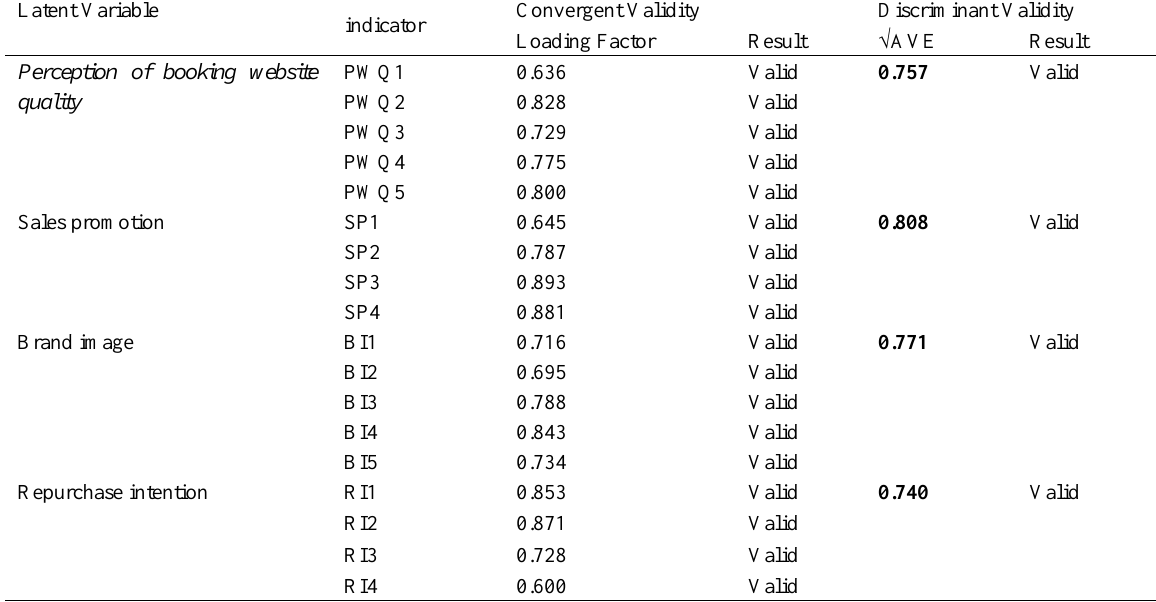
Table 3 : Validity